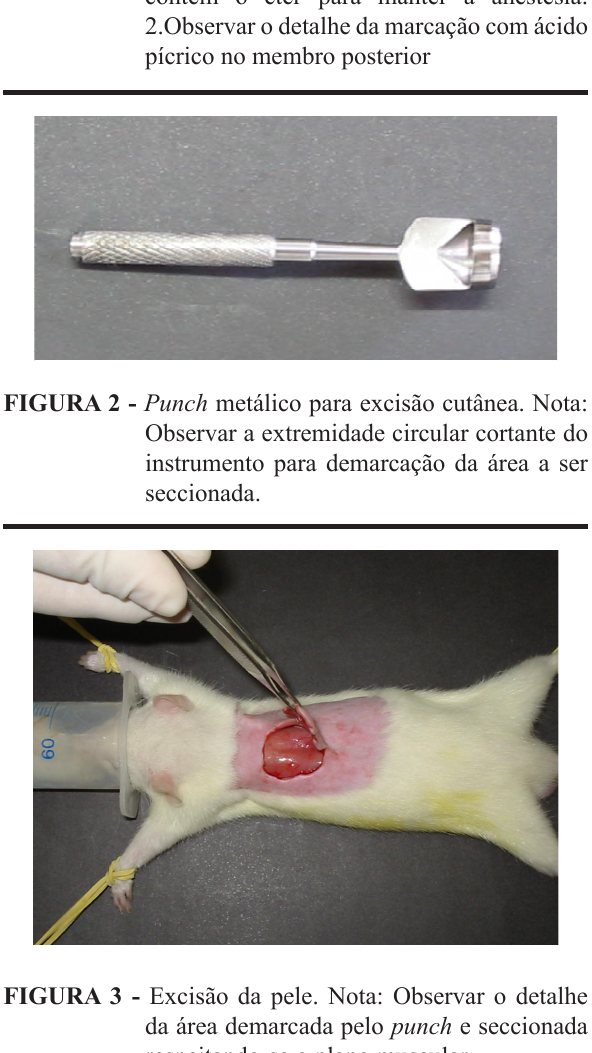
FIGURA 1 - Área epilada e aspecto da manutenção da anestesia. Nota : 1. Observar o detalhe da cabeça do animal dentro da seringa que contém o éter para manter a anestesia.